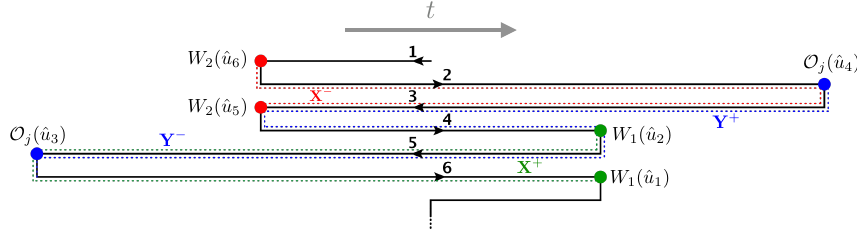
Figure 11 . Six-point configuration used to diagnose the collision. We indicate the parts of the contour where SL(2 , R ) parameters X ± and Y ± have